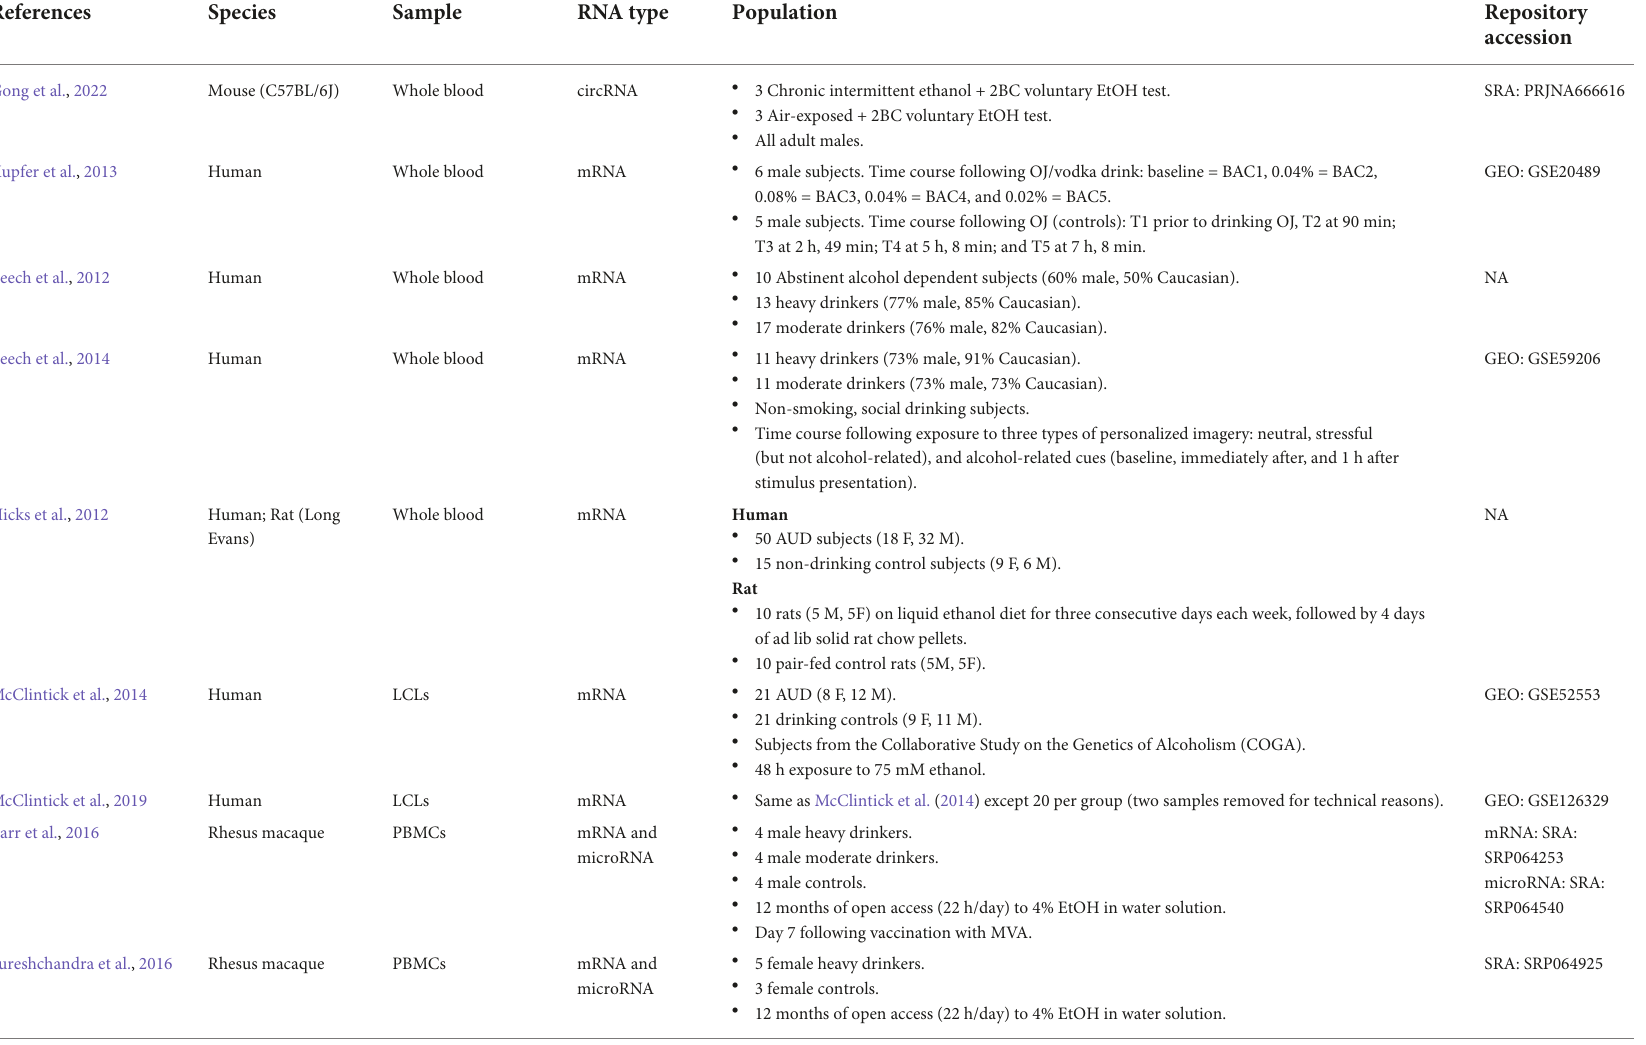
TABLE 3 Alcohol transcriptome studies in peripheral tissues (without biomarker performance